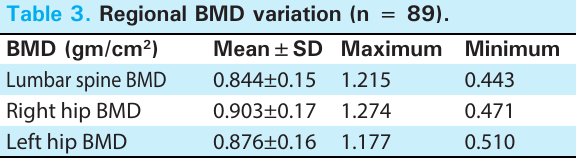
Table 3. Regional BMD variation (n = 89).